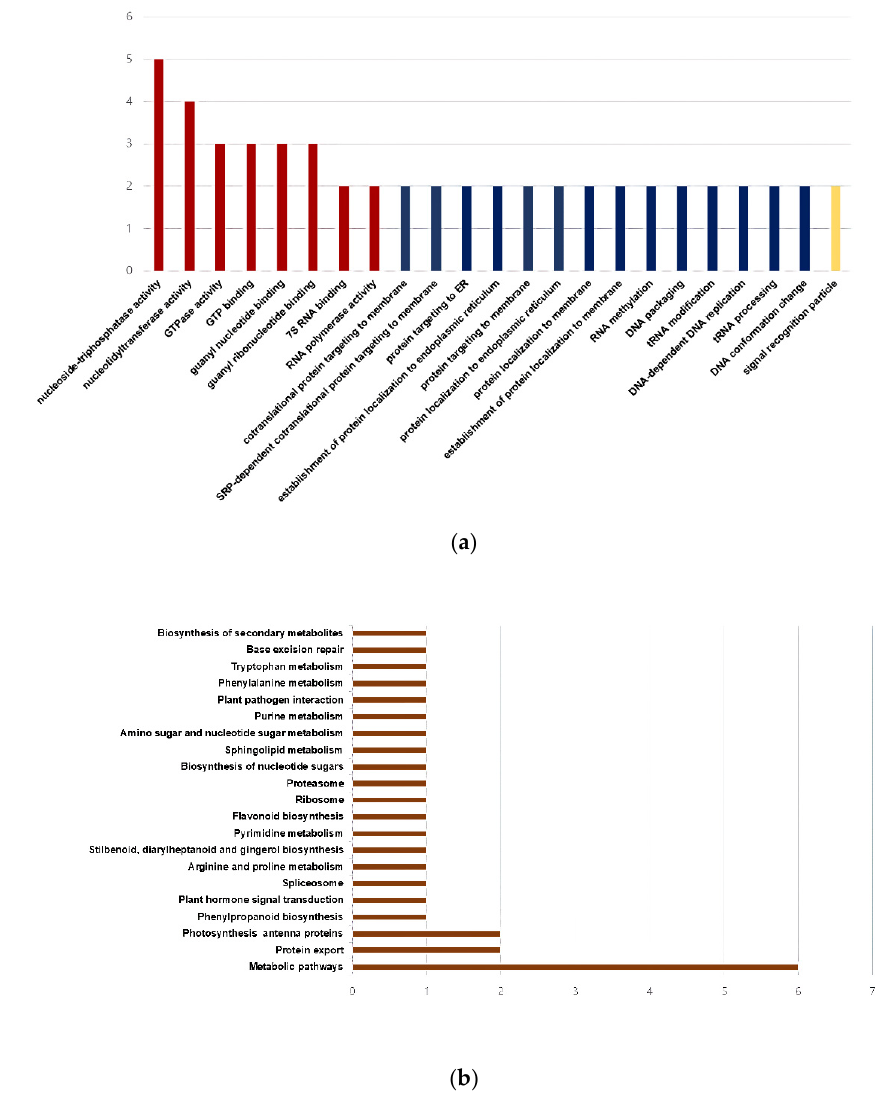
Figure 5. Functional annotation of simultaneously upregulated DEGs in the leaves and roots under salt stress between the two sorghum cultivars. ( a ) Gene annotation by GO analysis of DEGs. Gene annotation categories were composed of biological processes (red bars), molecular functions (blue bars), and cellular components (yellow bar). The y -axis represents the number of GO terms associated with the DEGs. The x -axis represents the GO terms. ( b ) Functional classification and pathway assignment of the identified DEGs by KEGG pathway. The y -axis represents the KEGG pathway, and the x -axis the number of KEGG pathways associated with the DEGs.